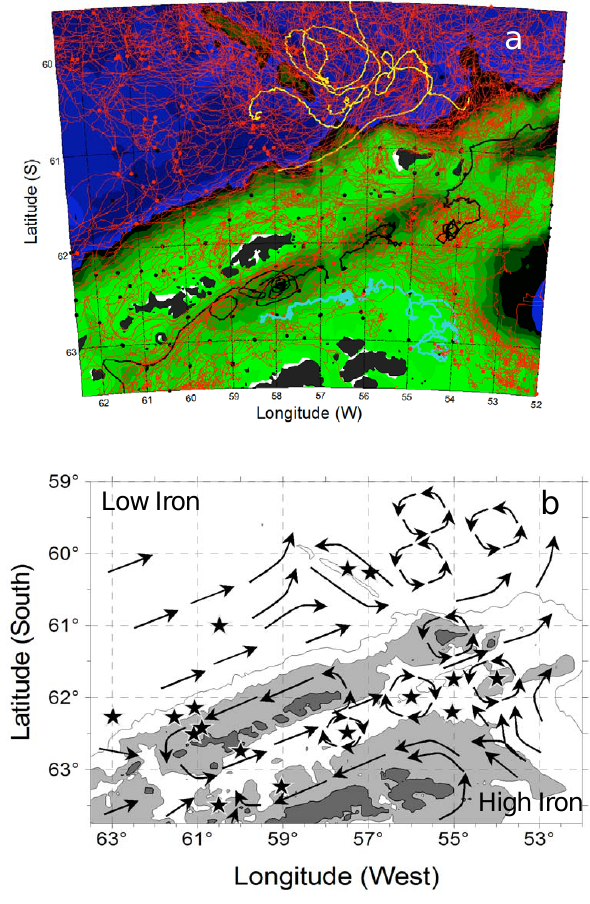
Fig. 10. Location of the 16 stations where Fe concentrations were determined in relation to water flow patterns in the Drake Passage- Antarctic Peninsula area. (a) , Drifter tracks (in red, yellow, and black) showing the complexity of surface water flow. Green areas indicate increasing depth of the shelf regions, with the darkest green representing 2000m depth. The small red and black circles indicate the location where each drifter was deployed. The drifter tracks in black illustrate the presence of eddies in Bransfield Strait. The drifter tracks in yellow show the effect of the Shackleton Transverse Ridge in steering water flow through the deep channel between the Ridge and Elephant Island, and the gyre-like tracks of the drifters to the east of the Ridge and north of Elephant Island. (b) Map of the sampling area showing generalized pattern of surface currents based on drifter track data, hydrographic data, and published wa- ter flow patterns. Figure has been modified from Fig. 1 in Hewes et al. (2009), but with more detail regarding water circulation. The darkest areas are islands and the northern tip of the Antarctic Penin- sula. The lighter grey areas are bounded by the 500m depth contour. The light continuous line is the 2000m isobath. The topographical features (just to the west of stations 12 and 13) in the Drake Passage are part of the Shackleton Transverse Ridge, portions of which are < 1000m in depth. The stars show the locations of the 16 stations where Fe concentrations were determined. For identification of the land and sea areas refer to Fig.